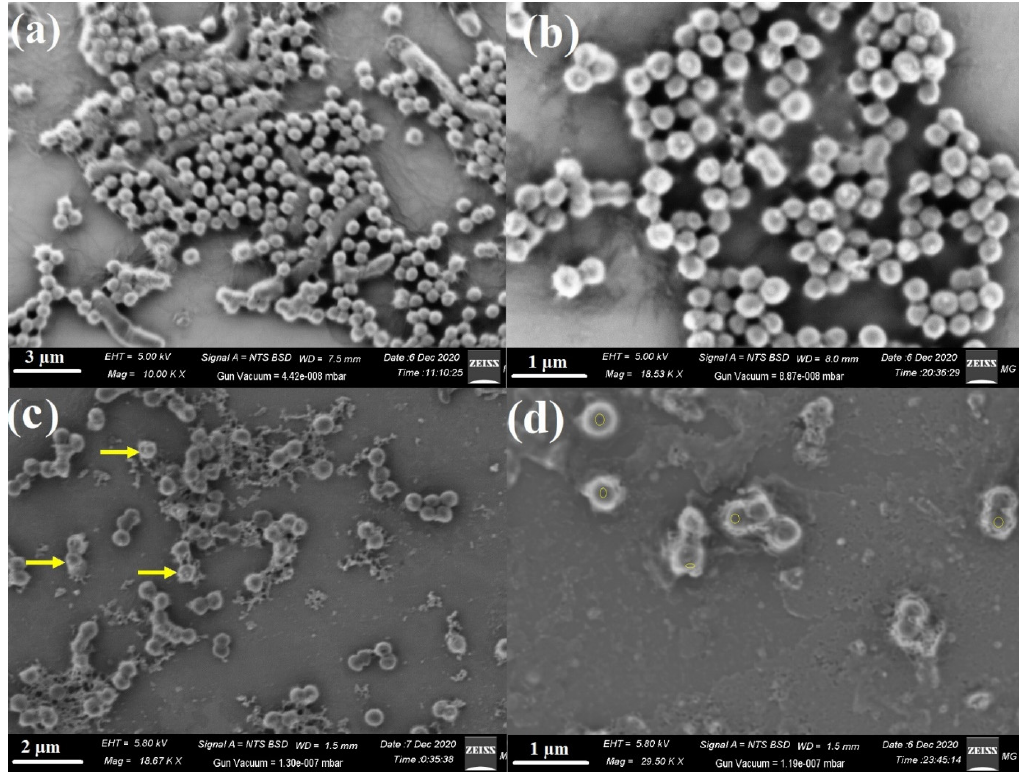
Figure 9. SEM images of S. Aureus ; ( a ) regular bacterial cells ( S. aureus ) without ZnCe x Fe 2 − x O 4 ; X = 0.06 treatment, ( b ) other magnified area regarding control S. aureus , ( c ) malformed and an irregular bacterial cells after ZnCe x Fe 2 − x O 4 ; X = 0.06 treatment showing full lysis (yellow arrows), and ( d ) other magnified area regarding treated S. aureus showing the formation of pits on the bacterial surface (yellow